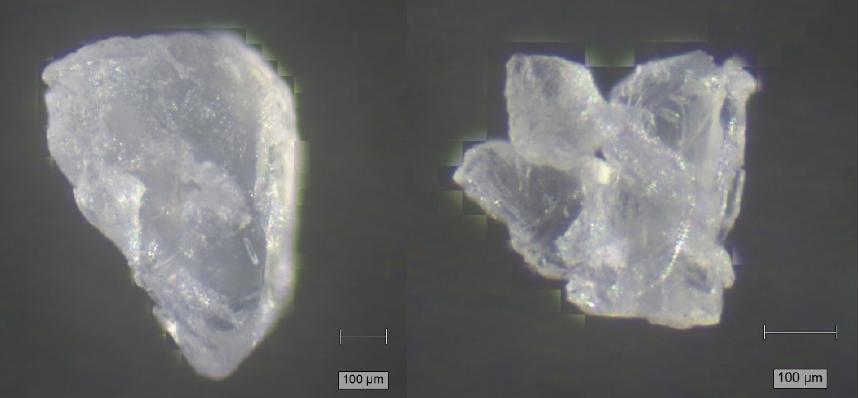
Figure 4. PE microplastic particles viewed using dark field microscopy. The left image is a non- irradiated PE particle, and the right image is post-high-dose irradiation.